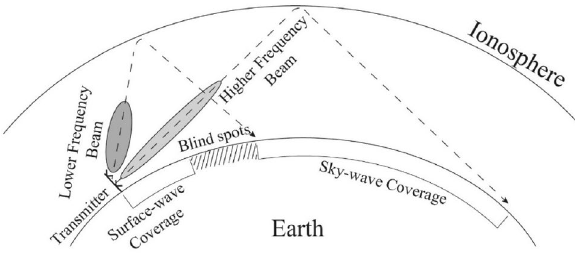
Figure 1. Illustration of sky-wave propagation.